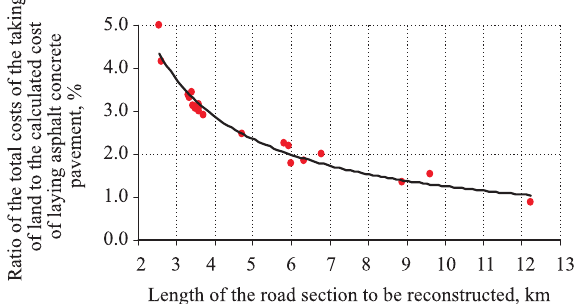
Fig. 4. Dependency of the ratio between the total costs of taking of land for the right-of-way and the calculated cost of laying asphalt concrete pavement on the length of the road section to be reconstructed